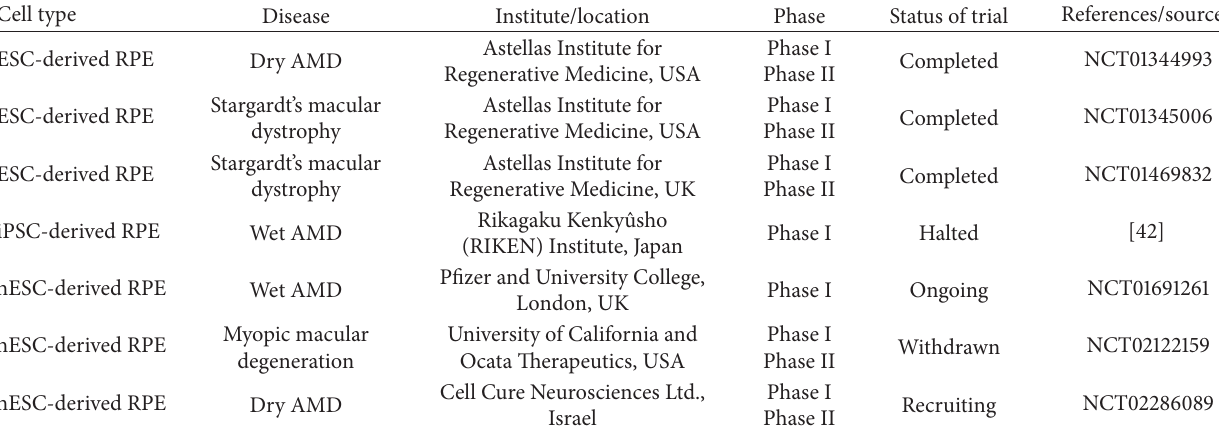
Table 1: Clinical trials of ESC/iPSC-based studies in ocular